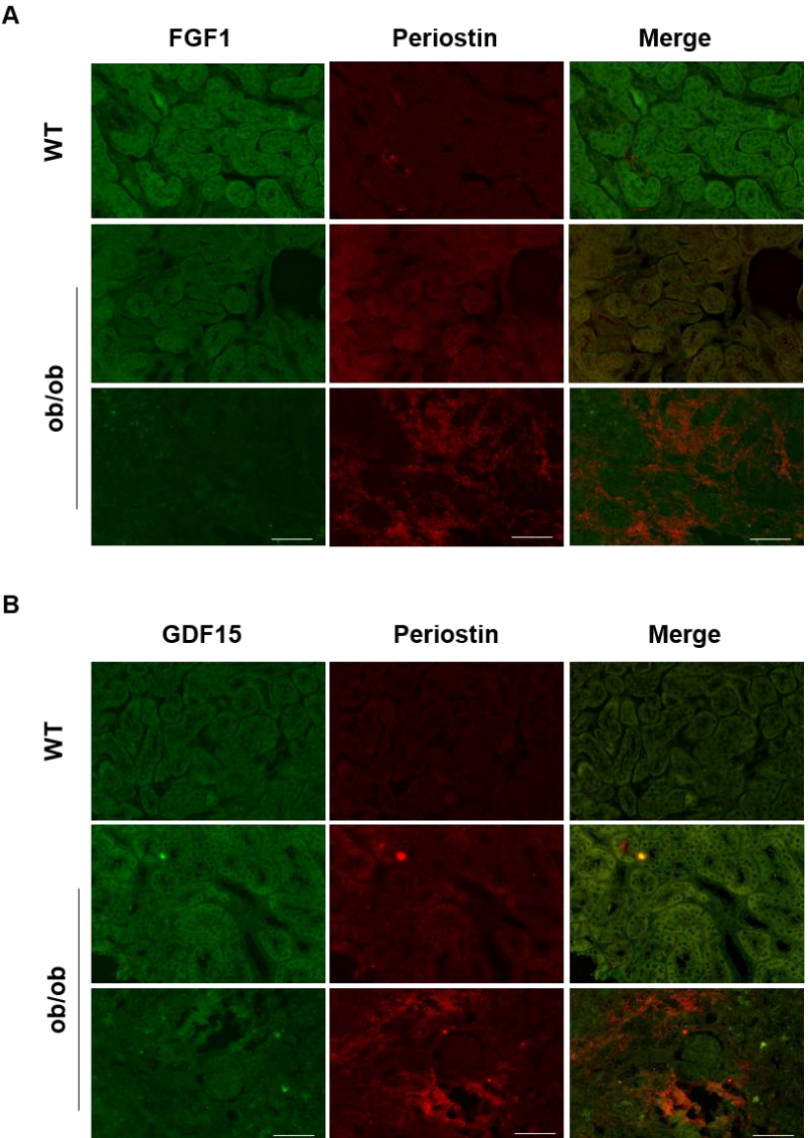
Figure 5. Periostin upregulation represses tubular FGF1 and GDF15 expression. Immunofluorescence of FGF1 and periostin ( A ). Immunofluorescence of GDF15 and periostin (×200) ( B ), Bars = 50 µM.